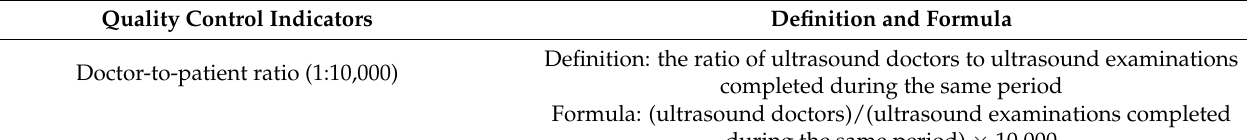
Table 1. Definition and meaning of the quality control